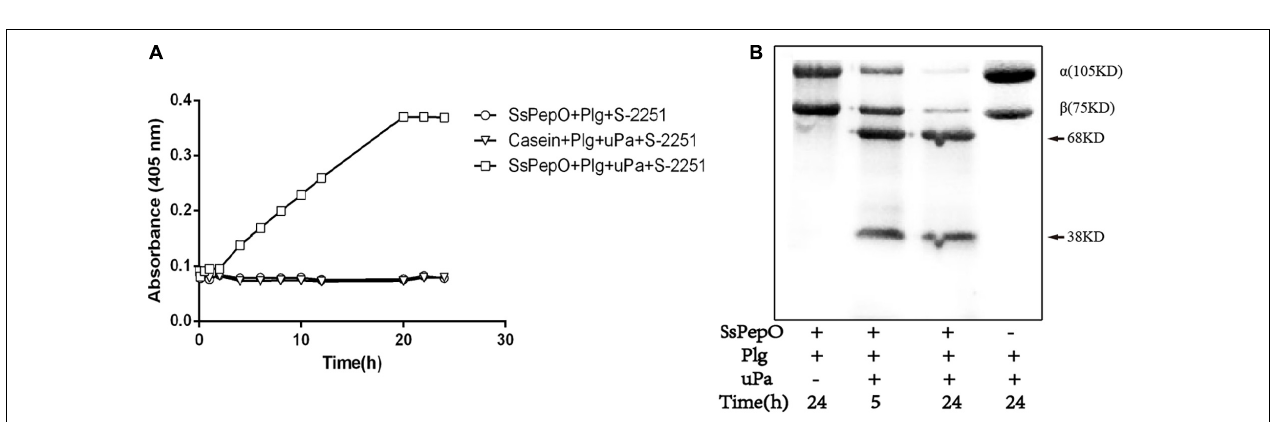
FIGURE 3 | Binding of plasminogen and fibronectin to SsPepO. SsPepO was immobilized on microtiter plates. (A,B) A constant amount of plasminogen (5 µ g/ml) along with increasing amounts of fibronectin (A) or a constant amount of fibronectin (5 µ g/ml) along with increasing amounts of plasminogen (B) was added. Bound fibronectin and plasminogen were detected using specific Abs. ns, not significant; ** p < 0.01; *** p < 0.001.